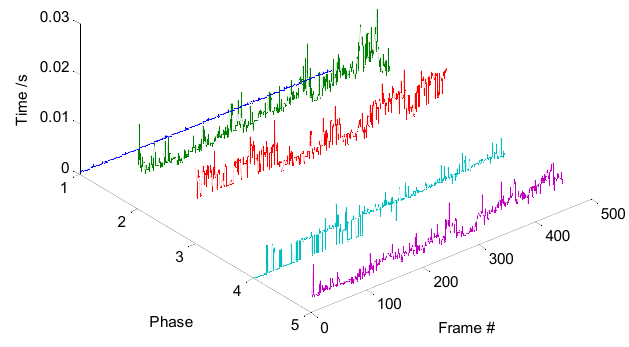
Figure 14. Regional-Distribution Tracker time